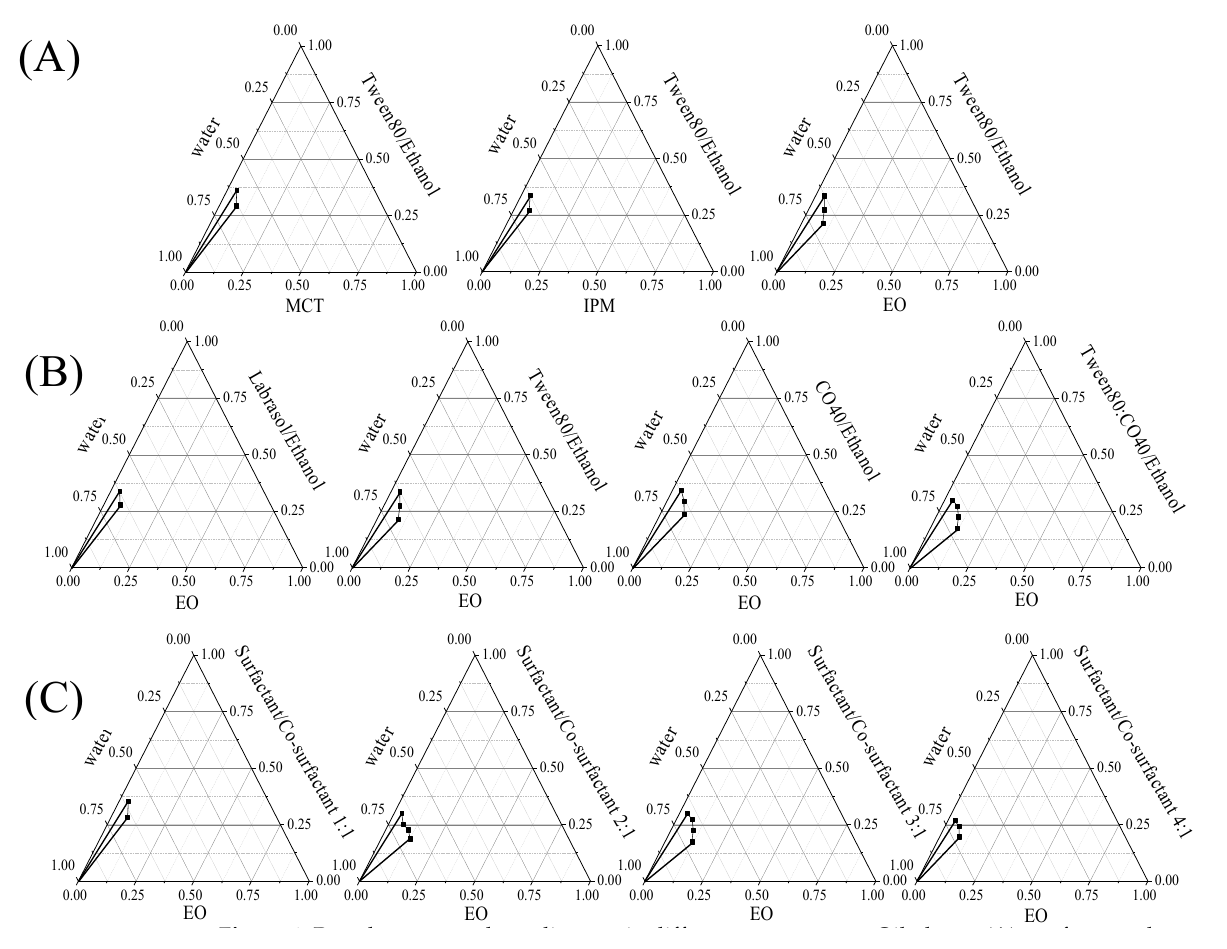
Figure 1. Pseudo-ternary phase diagram in different components. Oil phases ( A ), surfactant phases ( B ), and surfactant/co-surfactant ratios ( C ).